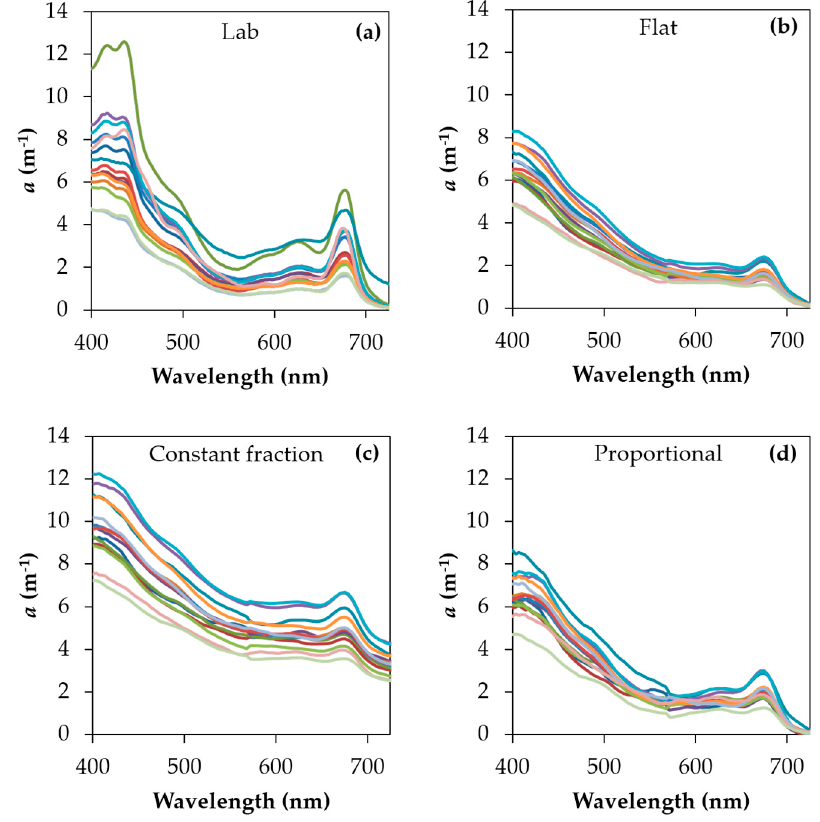
Figure 3. Measurements of a ( λ ) obtained by ( a ) laboratory spectrophotometry and acquired by an ac-s meter and previously corrected using ( b ) the flat, ( c ) constant fraction, and ( d ) proportional methods for the dataset collected in October 2014.